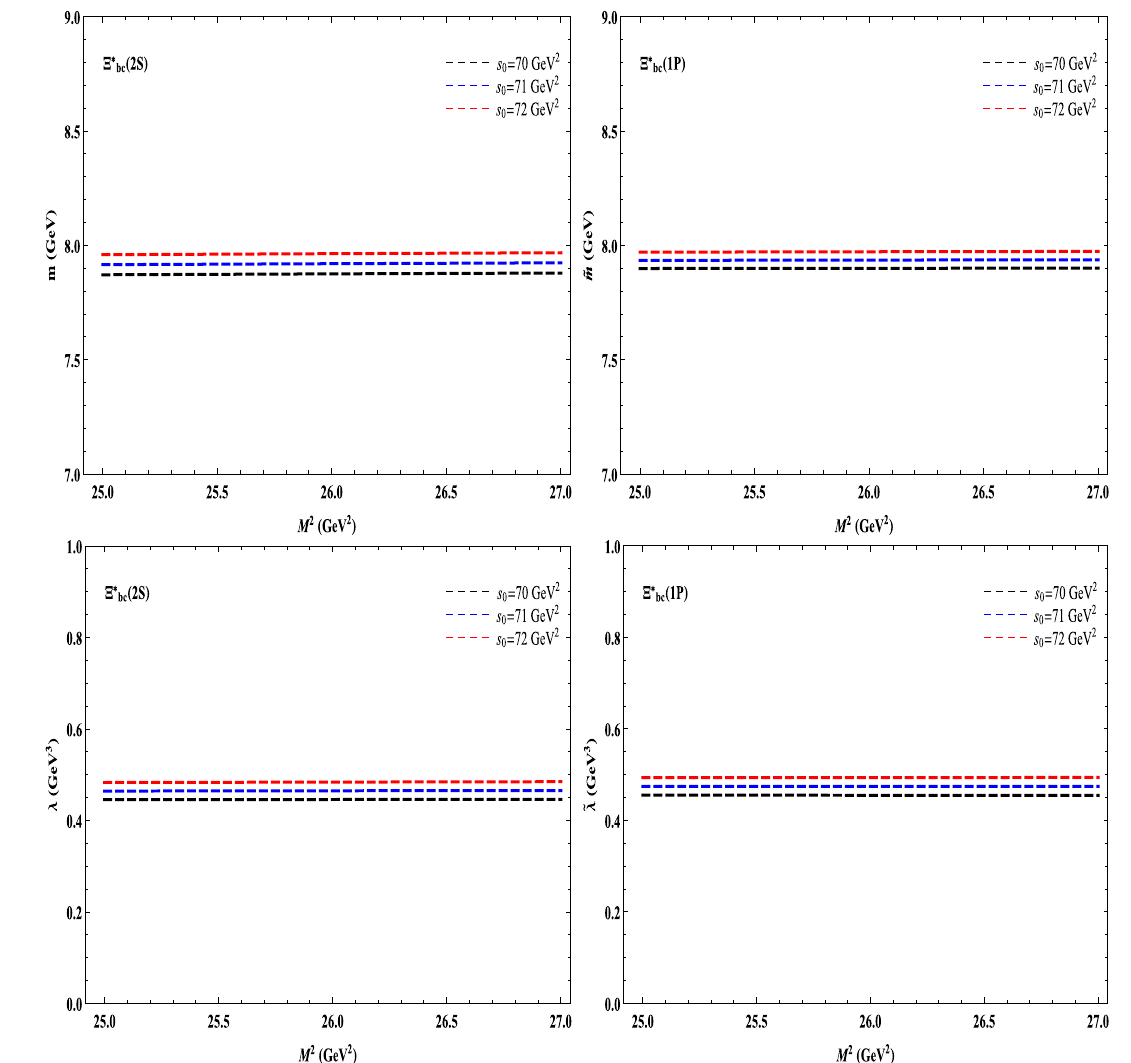
baryon on the Borel mass bc